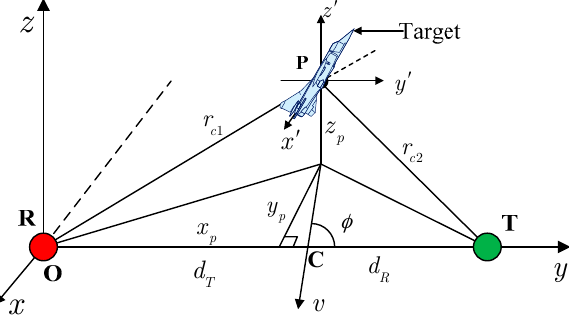
Figure 2. Typical forward scatter radar (FSR) topology.